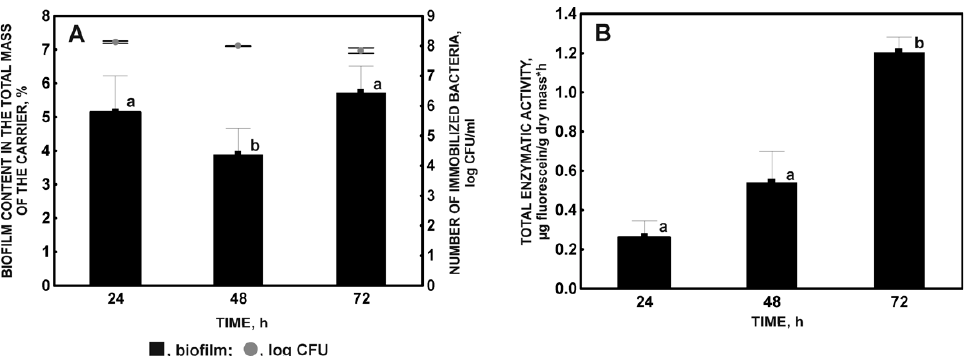
Figure 2. Biofilm content in the total mass of the sponge and the number of immobilized bacteria ( A ), and the total enzymatic activity of the immobilized microorganisms ( B ) in relation to the incubation time. Different letters indicate statistically significant differences (ANOVA, p < 0.05).